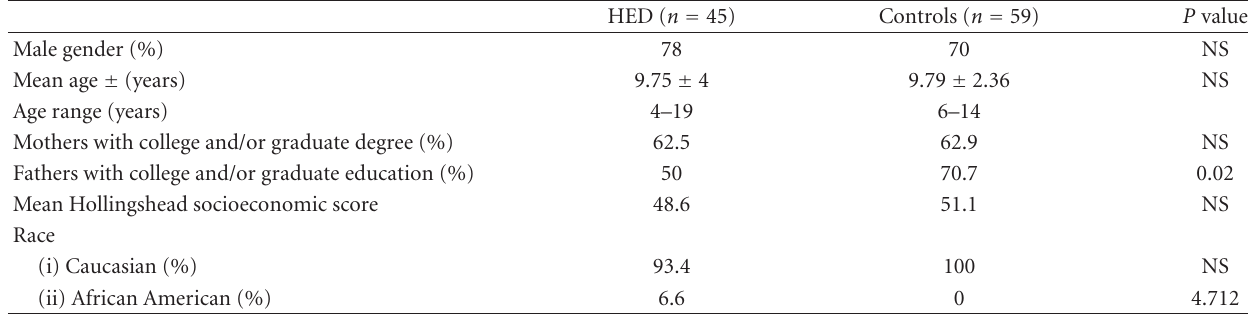
Table 1: Demographic characteristics of children with HED and control